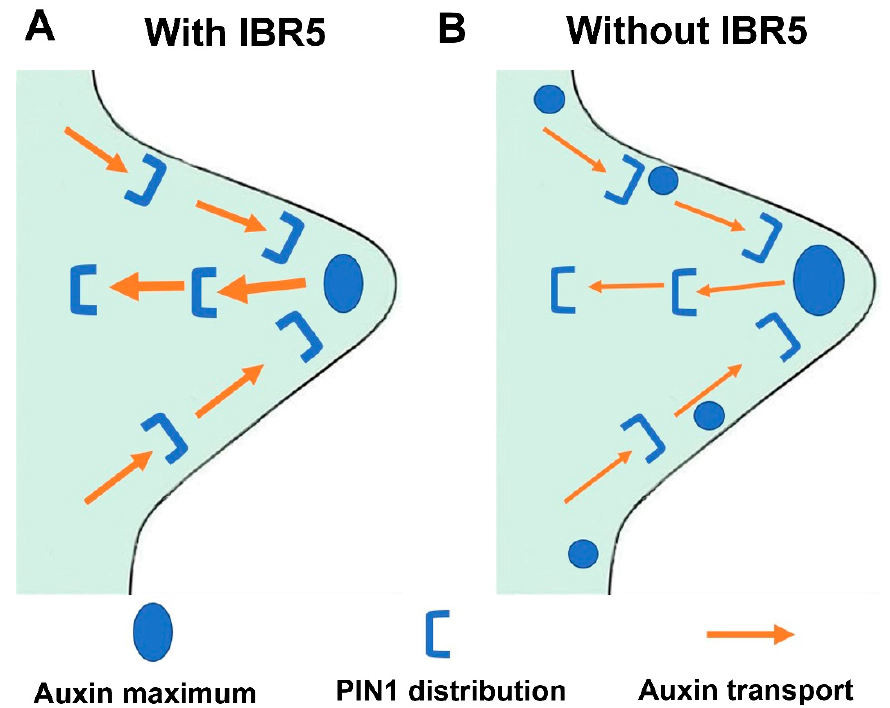
Figure 6. The schematic model for this work. ( A ) With IBR5, auxin maxima were restricted at the tips of leaf serrations. ( B ) Without IBR5, the distribution of PIN1 on the plasma membrane of the epidermal and cells around the leaf vein was compromised, the rate of auxin transport was reduced, and auxin maxima were enlarged and expended from the tip to the adjacent regions.